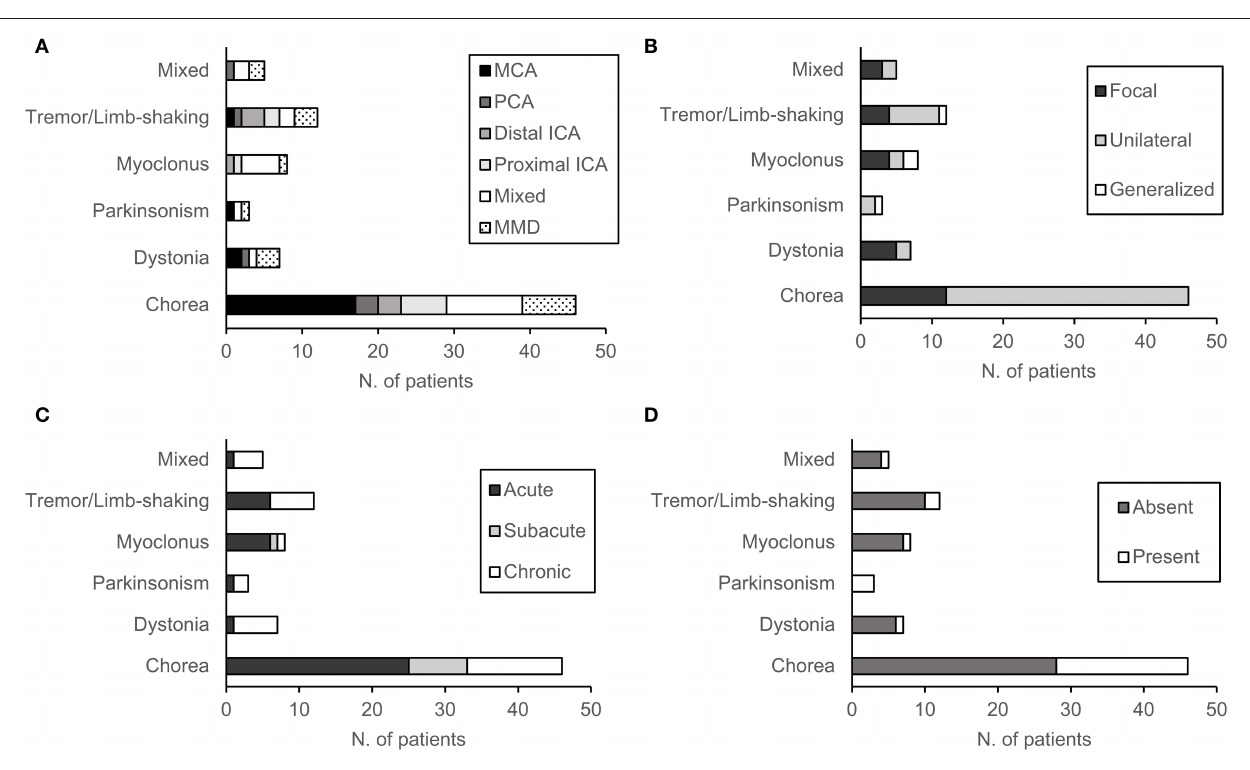
lesions ( n = 9). Between choreic (n = 46) and